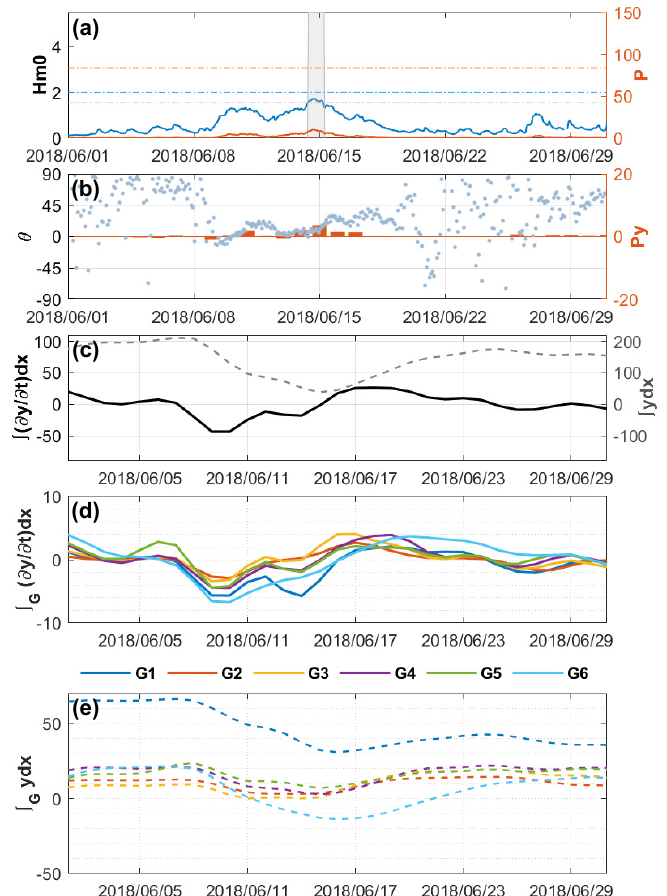
Figure 14. Changes in wave and beach parameters during June 2018. ( a ) Significant wave height and wave power, ( b ) wave direction and longshore component of wave power, ( c ) longshore transport rate (solid line) and integrated beach width (dashed line), ( d ) longshore transport rate for each sector, and ( e ) integrated beach width for each sector.